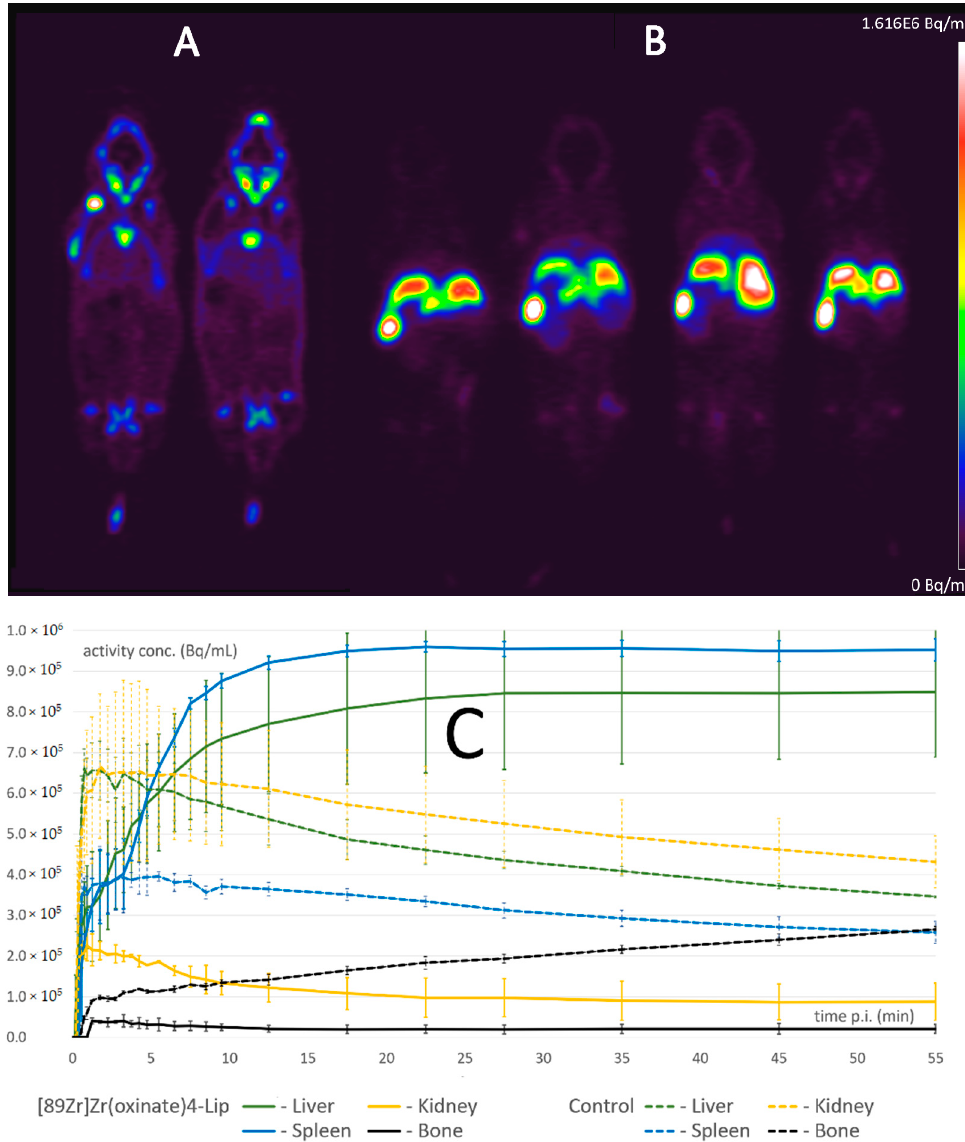
Figure 2. ( A ) Representative PET slices of two mice from the [ 89 Zr]Zr(OH) 2 (C 2 O 4 ) control group 24 h post-injection, and ( B ) of four mice that received the [ 89 Zr]Zr(oxinate) 4 –liposomes. ( C ) Time—activity curves of selected organs (liver, spleen, kidney and bone) generated from the dynamic PET imaging data over 55 min post-injection.